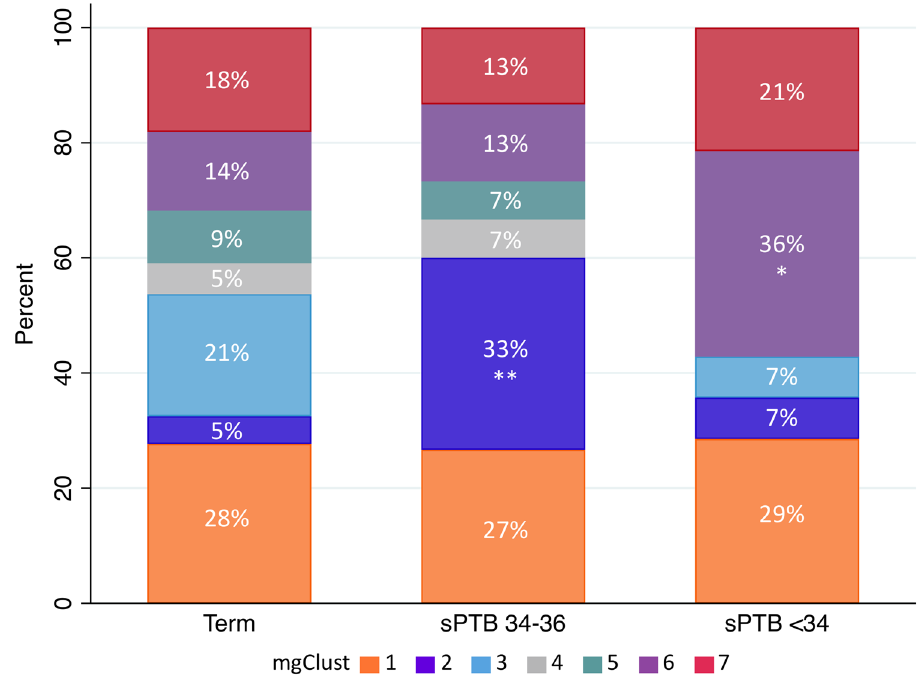
Figure 6. Prevalence of metagenomic clusters (mgClust) at 16–20 gestational weeks among participants with term birth, spontaneous preterm birth at 34–36 weeks (sPTB 34–36), and spontaneous preterm birth before 34 weeks (sPTB < 34). Relative percents weighted for sampling and p values calculated by weighted Poisson regression of prevalence of mgClust between preterm birth outcomes compared to term; * p < 0.05; ** p < 0.001.